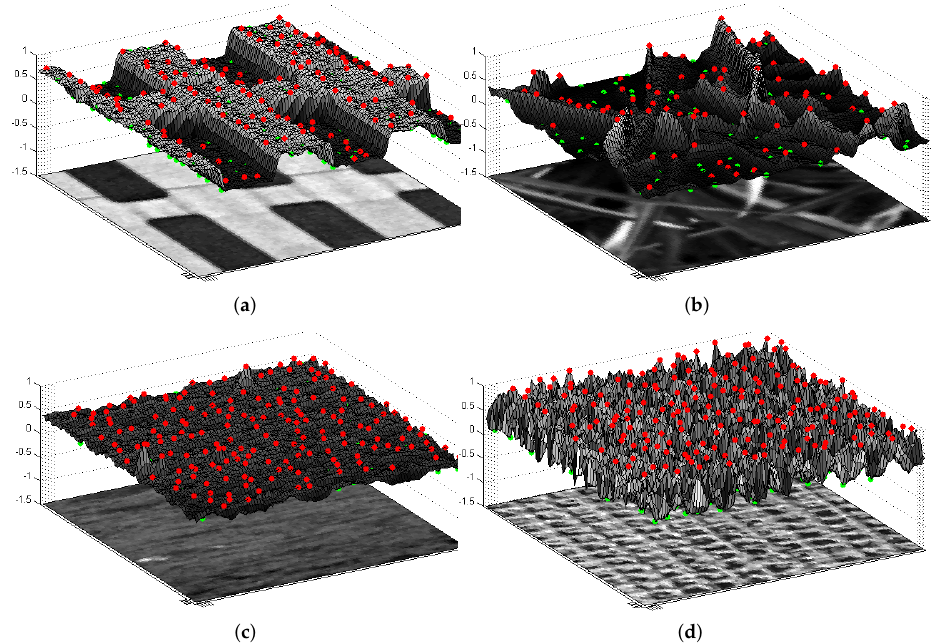
Figure 1. Illustration: spatial distribution and arrangement of local maximum pixels (in red) and local minimum pixels (in green) within four different textures (size of 100 × 100 pixels) extracted from the Vistex database [37]: Buildings.0009 , Leaves.0016 , Water.0005 and Fabric.0017 . The local extrema are detected using a 5 × 5 search window. The figure is better visualized in colors. ( a ) Buildings.0009 ; ( b ) Leaves.0016 ; ( c ) Water.0005 ; ( d ) Fabric.0017